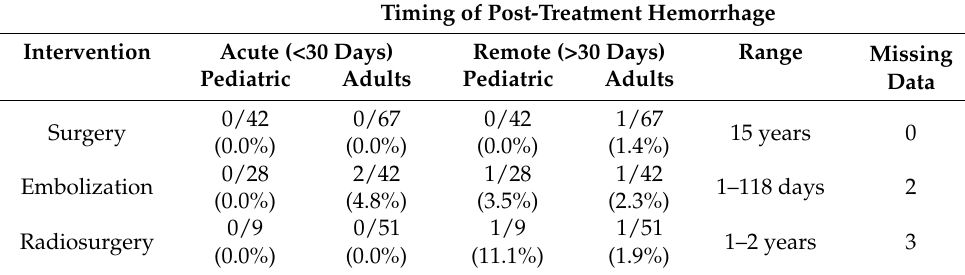
Table 4. Timing of Post-treatment Hemorrhage by Intervention. Timing of Post-Treatment Hemorrhage